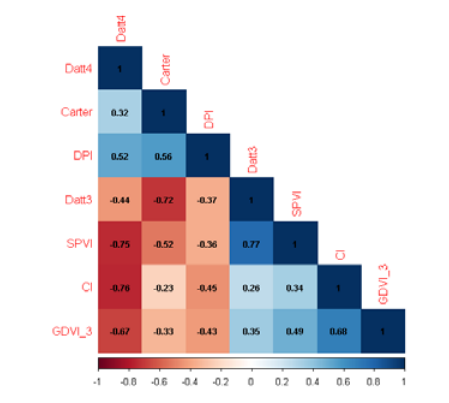
Figure 8 - Correlation of filtered features at cut-off =